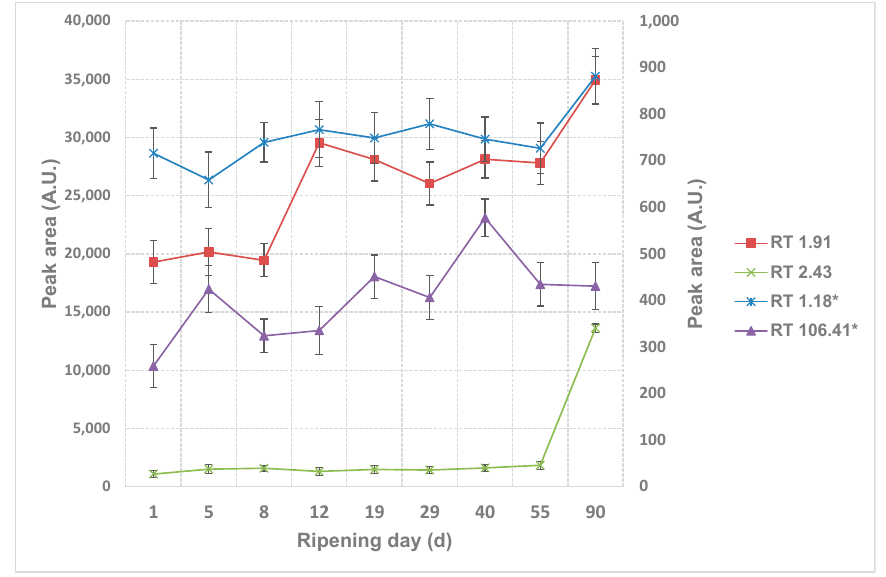
Figure 2. The evolution of peptides throughout the ripening process. ASN fraction where 4 main peaks are observed. RT: retention time of the selected peak. * Values in the secondary axis.